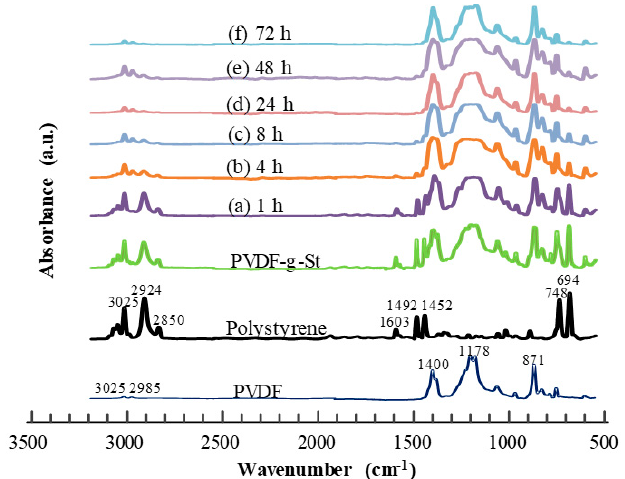
Figure 2. FTIR/ATR spectra of the residual PVDF– g –St film after xylene extraction with different times (a–f) together with those of the starting PVDF– g –St film, commercial polystyrene, and pristine PVDF film.